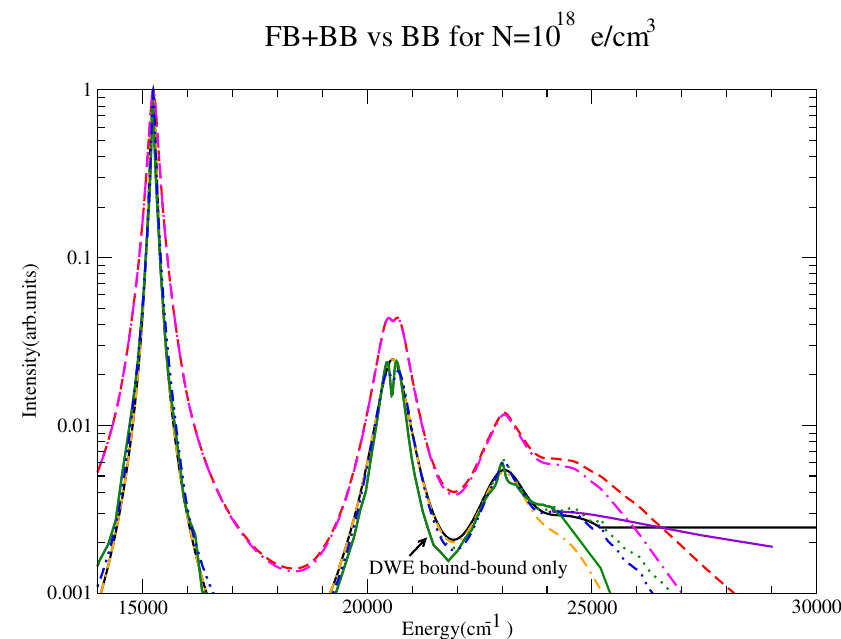
Figure 26. BB + FB vs. BB comparison for the intermediate density close to the continuum. Shown are QC-FFM for BB + FB (solid) and BB only (dot-double dashed), CONVST for BB + FB (dashed) and CONVST for BB only (dash-dotted) and CONVPST for FB + BB (dotted) and BB only (dash-double dotted). Also shown is DWE (green solid) for the BB